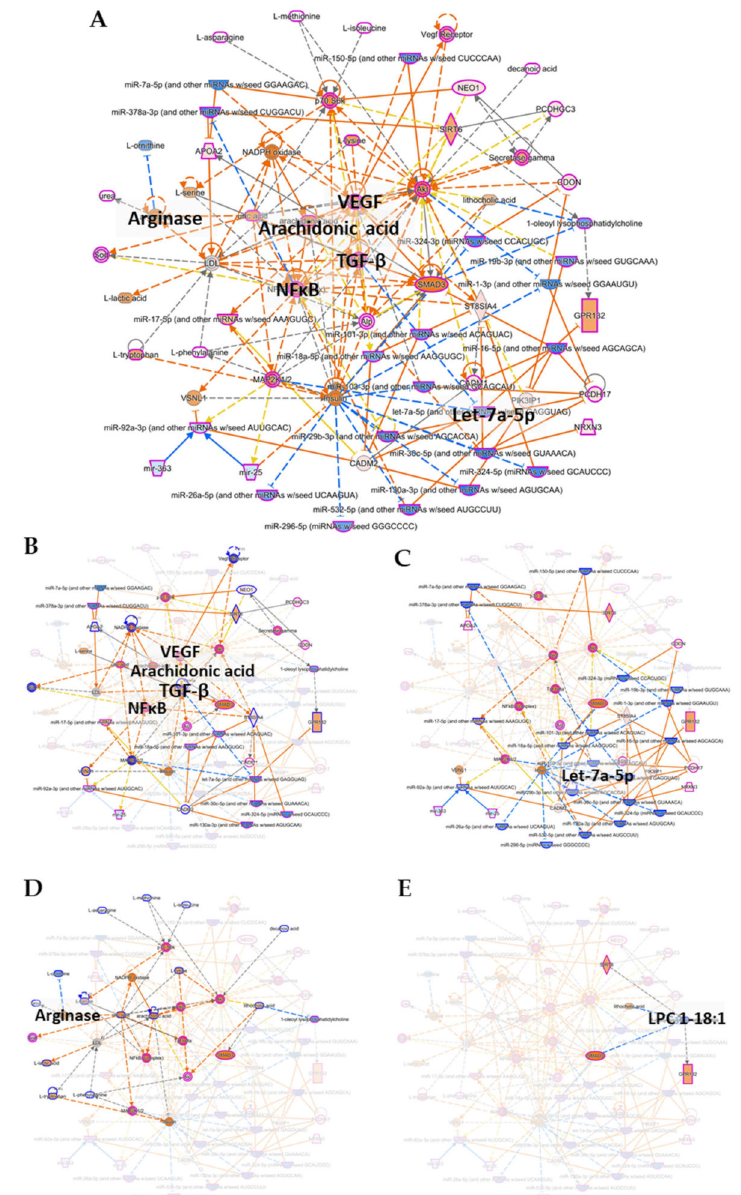
Figure 5. Integrated molecular network analysis in combined quadra-omics datasets highlights the potential for identifying integrated biomarker signatures of T1D. The integrated quadra-omics dataset was analyzed in IPA using the “Molecular Network Prediction” module with a focus on immune/inflammatory processes. The integrated global network shown in ( A ) was obtained at the cutoff value of 1.1 and was curated to reduce complexity and highlight nodes with known involvement in T1D, namely, NF- κ B, TGF- β , VEGF, arachidonic acid, arginase, and the microRNA Let-7a-5p (Let-7) family. Individual contributions to this network by each omics-type dataset are highlighted in full color and some nodes annotated (for emphasis) with the rest of the network faded in the background (for clarity): ( B ) proteomics, ( C ) small transcriptomics, ( D ) metabolomics, and ( E ) lipidomics. Network elements are represented by symbols of various marker shapes for identification and different colors for activation or inhibition. Marker shape key—horizontal-oval: transcription regulator; vertical-oval: transmembrane receptor; diamond: enzyme; square: cytokine; vertical-rectangle: G-protein coupled receptor; broken-lined vertical-rectangle: ion channel; and horizontal-diamond: peptidase. Marker color key—orange: predicted activation, blue: predicted inhibition. Connecting line color key—orange: activation; blue: inhibition; yellow: findings are inconsistent with the state of the downstream molecule; and gray: not predicted. High resolution versions of these networks are provided in the Supplementary Figure